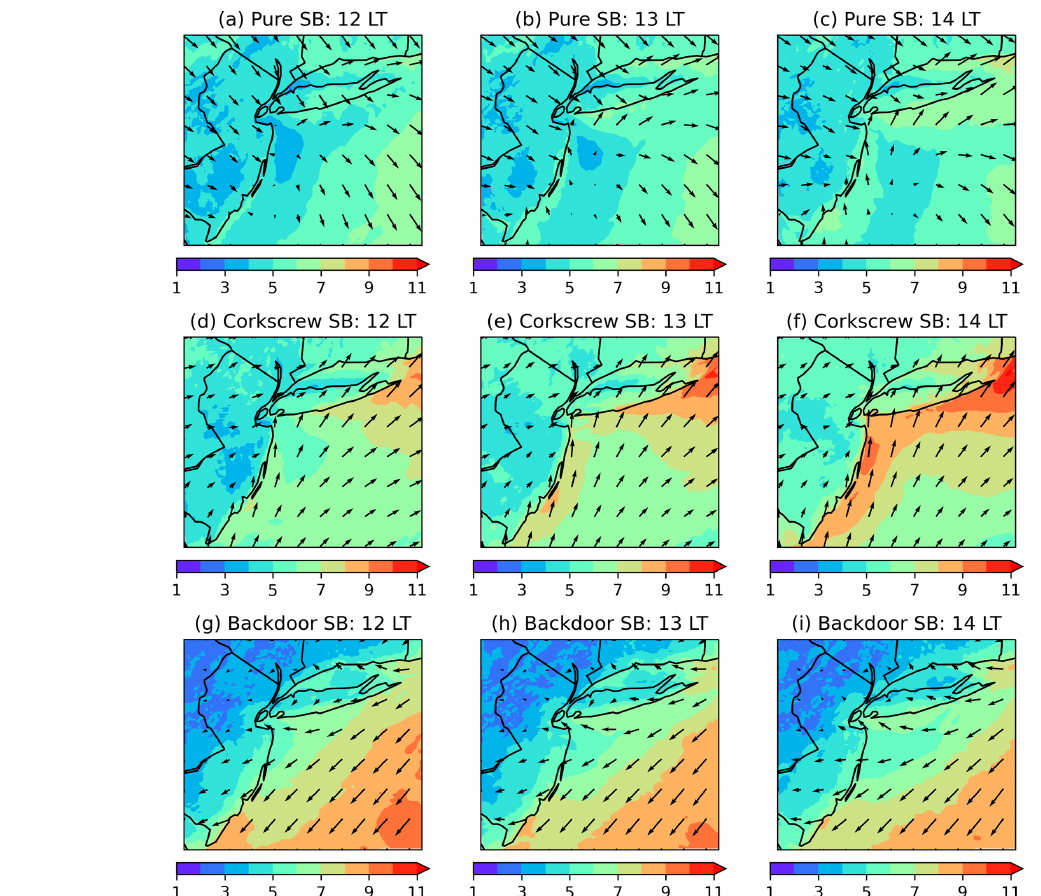
Figure 11. Spatial pattern of hub-height level wind speed and wind direction from the composite average for the pure sea breezes (a–c) , corkscrew sea breezes (d–f) and backdoor sea breezes (g–i) at 12:00, 13:00 and 14:00LT. The colored contours indicate the magnitude of wind speed (ms − 1 ), and the vectors show the wind